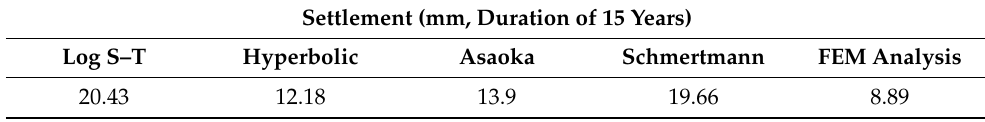
Table 6. Summary of long-term settlement analysis results of the DCM foundation